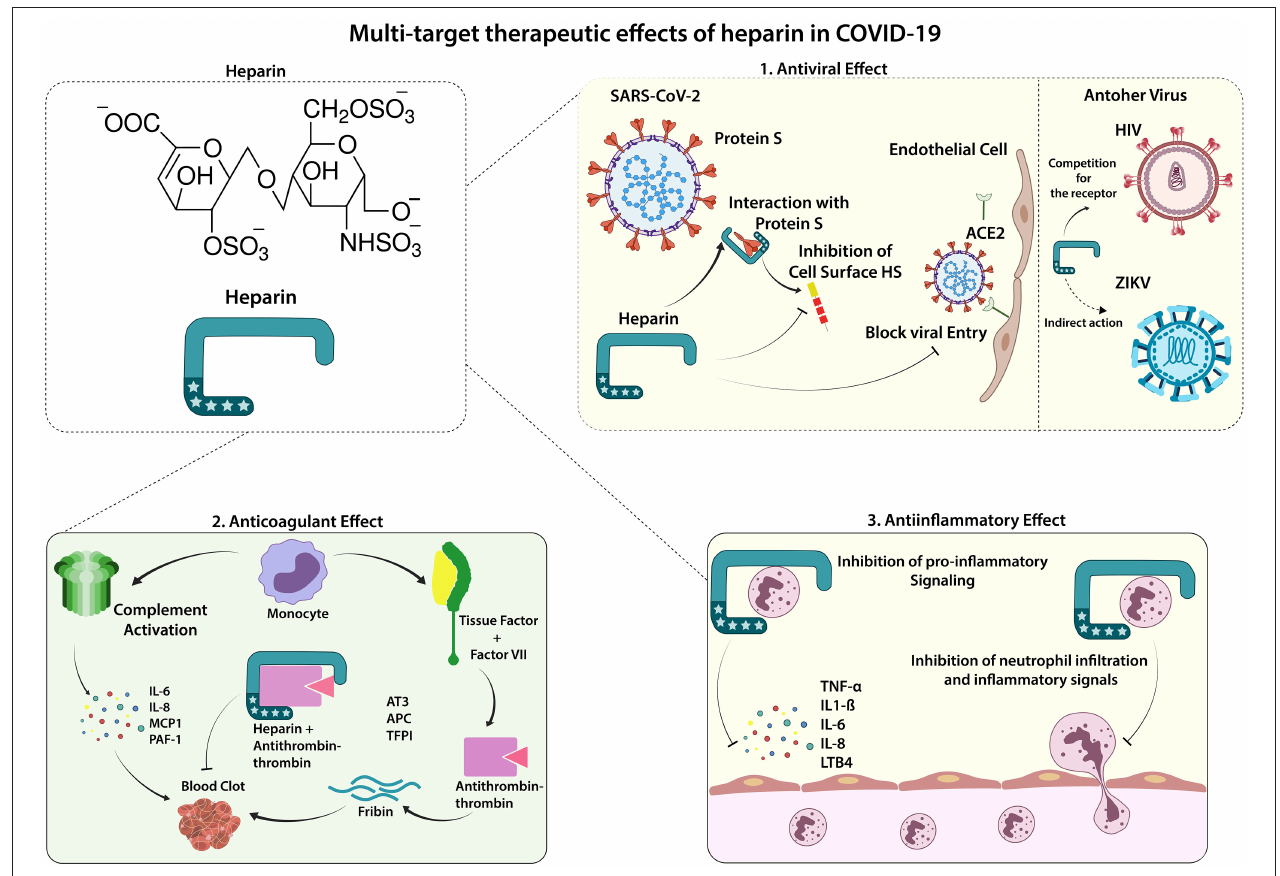
FIGURE 1 | Therapeutic Effects of Heparin in COVID-19. Lung infection by SARS-CoV-2 can trigger a systemic inflammatory process, which is also associated with an increased occurrence of procoagulant factors found in severe cases of COVID-19. Low molecular weight Heparin (LMWH) shows effects in 3 main ways: 1. Antiviral effect: the entrance of SARS-CoV-2 in the endothelial and epithelial cells depends on its interaction with the cell surface heparan sulfate; thus, the binding of heparin to the viral spike protein can inhibit this interaction, decreasing viral cell invasion. Heparin has shown its antiviral effect on other viruses such as HIV (competing for the receptor) and ZIKV (indirect action, abrogating the viral-induced cytotoxic effect). 2. Anticoagulant effect: the uncontrolled blood clot formation can be controlled by the anticoagulant function inherent to heparin, mediated by the interaction of heparin and anti-thrombin-3 glycoprotein (AT3), potentiating the AT3 inactivation of thrombin, an essential factor for the formation of thrombi. 3. Anti-inflammatory effect: heparin has widely known anti-inflammatory effects, mainly canceling pro-inflammatory mediators, such as TNF- α , IL-6, and LTB4, which leads to decreased migration and activation of immune cells, preventing against the systemic inflammatory response. ACE2, Angiotensin-converting enzyme 2; APC, activated protein C; AT3, Antithrombin-III; CK, creatine kinase; CRP, C-reactive protein; ESR, erythrocyte sedimentation rate; HS, heparan sulfate; IL, interleukin; LDH, lactate dehydrogenase; PAI-1, Plasminogen activator inhibitor 1, TF, Tissue factor, TFPI, Tissue factor pathway inhibitor; TNF, Tumor necrosis factor; VII, Factor